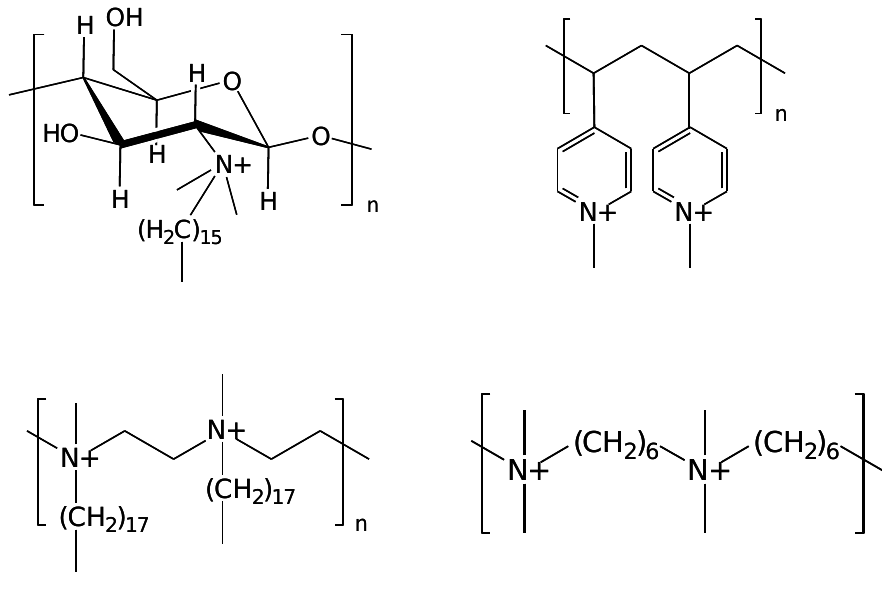
Figure 3. Typical structures of biocidal polymers with quarternary ammonium